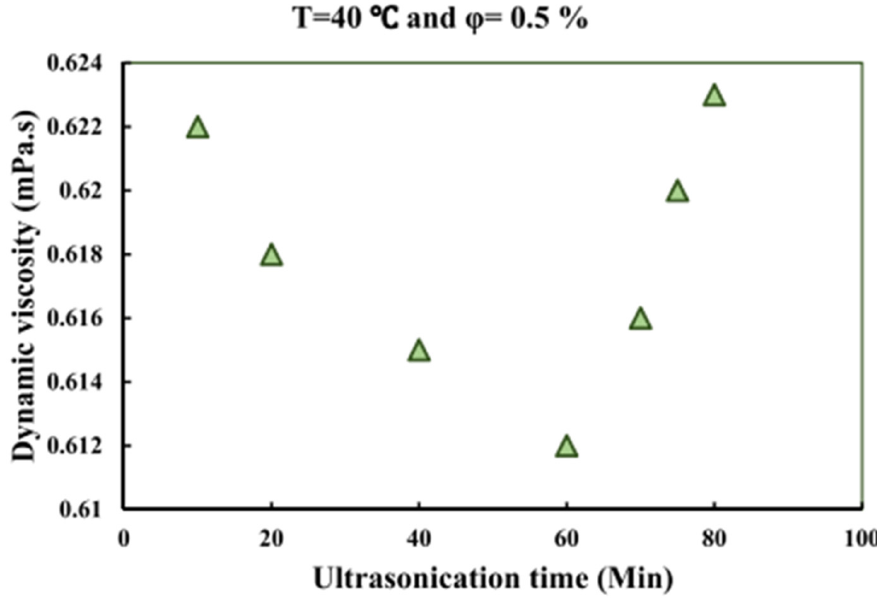
Figure 5. Viscosity of MWCNT/water NF against ultrasonication time at the temperature of 40 °C and concentration of 0.5%. Adapted from [149].